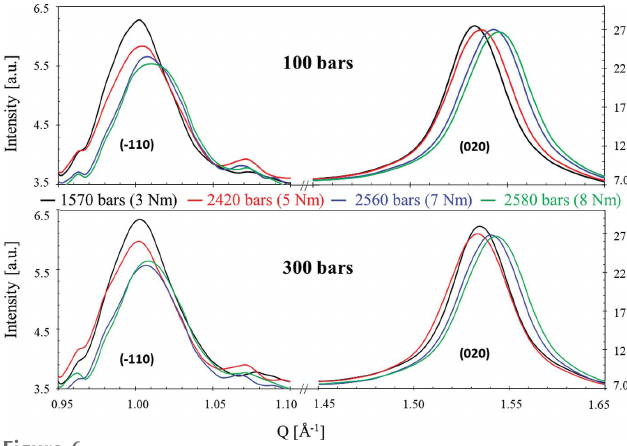
Figure 6 Influence of the compressive pressure at fixed hydrostatic pressure (100 bar and 300